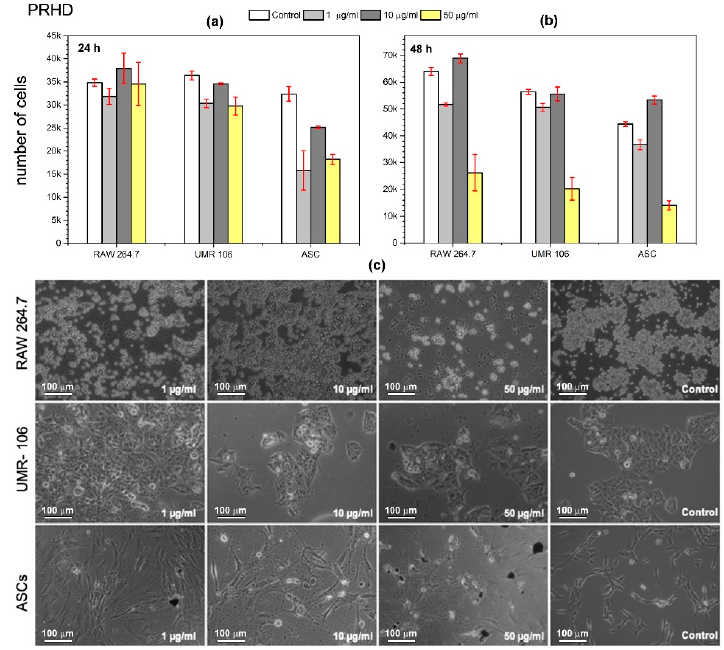
Figure 9. Effect of in vitro PRHD stimulation of macrophages (RAW 264.7), osteosarcoma (UMR-106), and stem (ASCs) cells proliferative activity as a function of concentration ( a ) after 24 h and ( b ) after 48 h of exposure. Panel ( c ) shows morphology changes of macrophages (RAW 264.7), osteosarcoma-derived cells (UMR-106), and stem cells (ASCs) after 48 h in vitro exposure to PRHD nanoparticles and control.